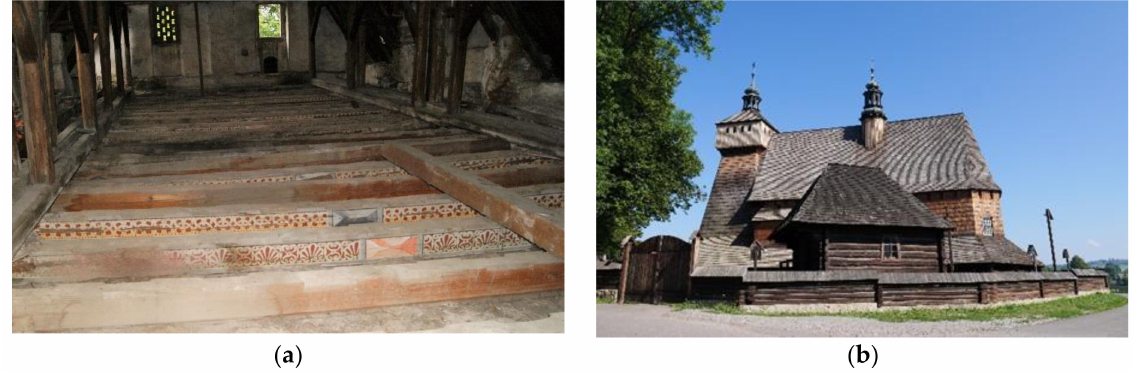
Figure 1. ( a ) The beam ceiling of the Gorzan ó w Palace—high humidity of the elements resulted from long-term leakage in the roofing; ( b ) The church in Hacz ó w—repeatedly flooded by